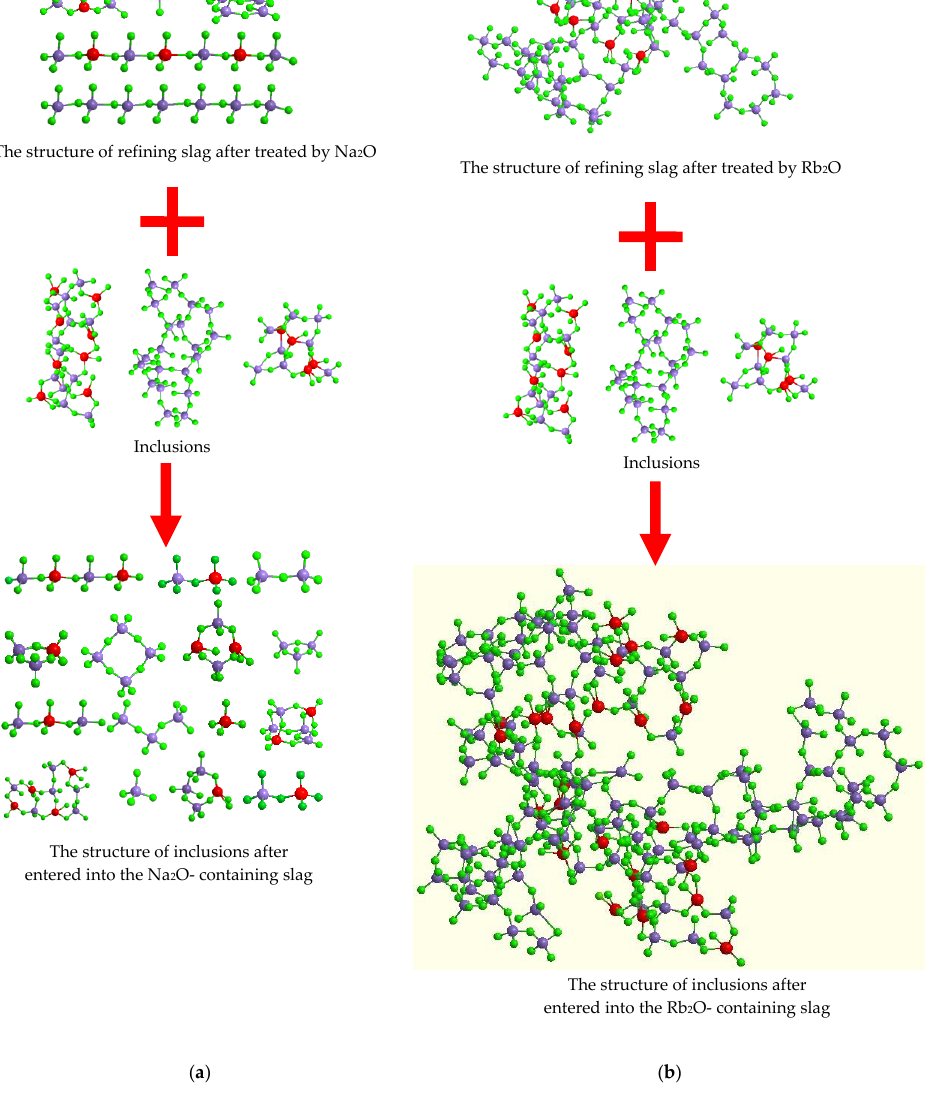
Figure 25. The schematic diagram of the dissolution model of inclusions in refining slag ( a ) containing Na 2 O; ( b ) containing Rb 2 O.